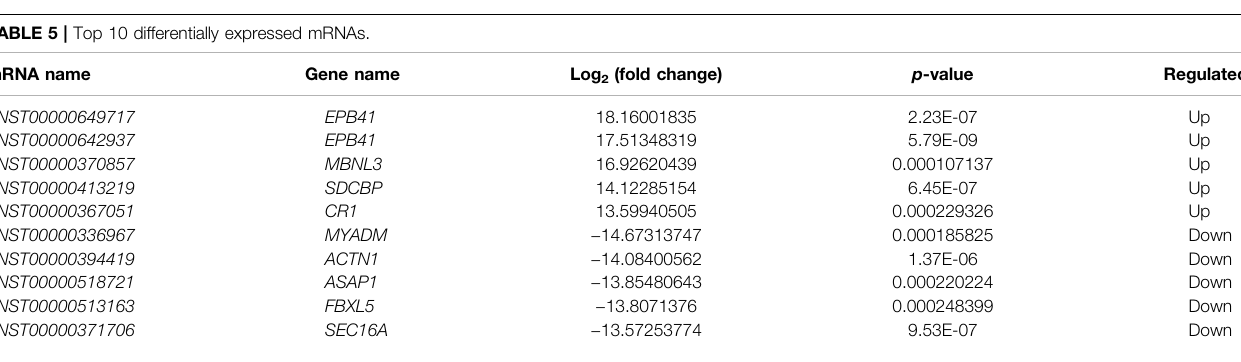
TABLE 5 | Top 10 differentially expressed